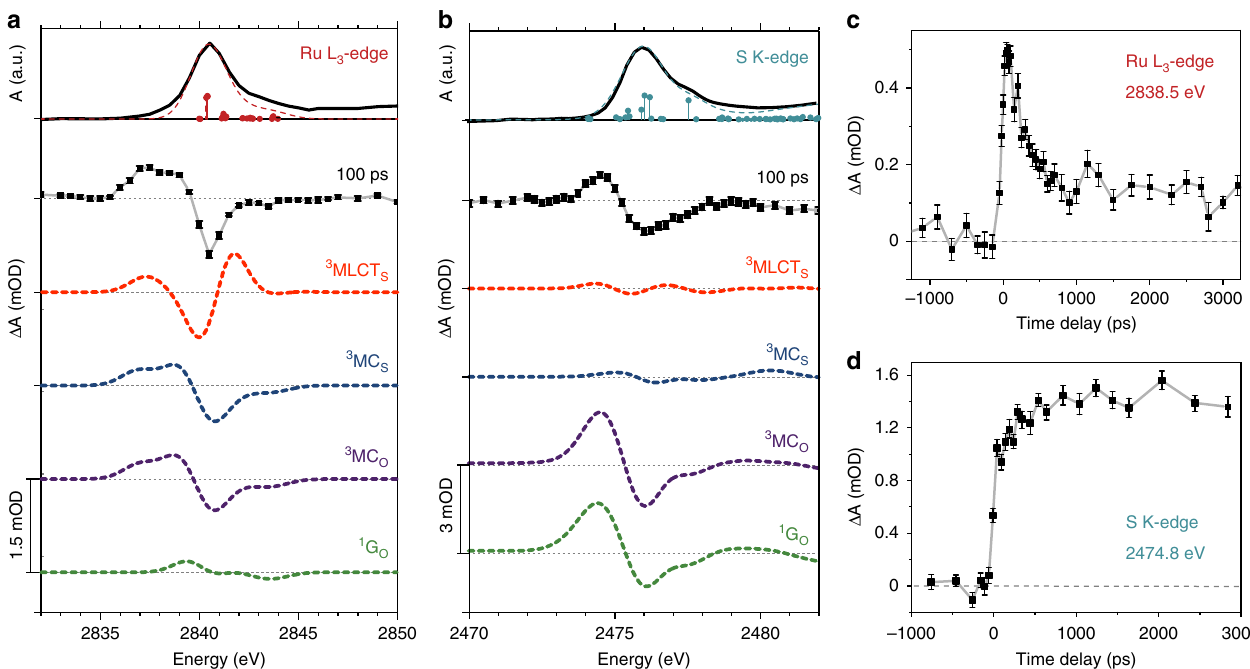
Fig. 3 Results of TR-XAS measurements and comparison with TD-DFT simulated spectra. Measured and simulated data at the Ru L 3 -edge ( a ) and S K-edge ( b ). Top panel (solid black trace) is the measured absorption spectrum of [Ru(bpy) 2 (pyESO)](PF 6 ) 2 in the S-bonded ground state. The TD-DFT predicted transitions are indicated as sticks and the predicted spectrum is shown by the dashed line (overlaid with the measured spectrum). Below (second from top, square points) is the measured transient differential absorption spectrum at 100 ps time delay. Error bars indicate the standard error of the mean (obscured in some cases by the large size of the data points). All dashed traces below are TD-DFT simulated differential spectra of several proposed excited state intermediates (S-bonded triplet MLCT and MC states: 3 MLCT S and 3 MC S ; O-bonded MC state: 3 MC O ) and the O-bonded ground state ( 1 G O ). The transient measured and simulated difference spectra are all plotted on the same vertical scale, with the amplitude indicated by the scale bars. c Fixed energy time-delay scan measured at the Ru L 3 -edge (2838.5 eV), including error bars indicating the standard error of the mean. d Fixed energy time-delay scan measured at the S K-edge (2474.0 eV), with error bars indicating the standard error of the